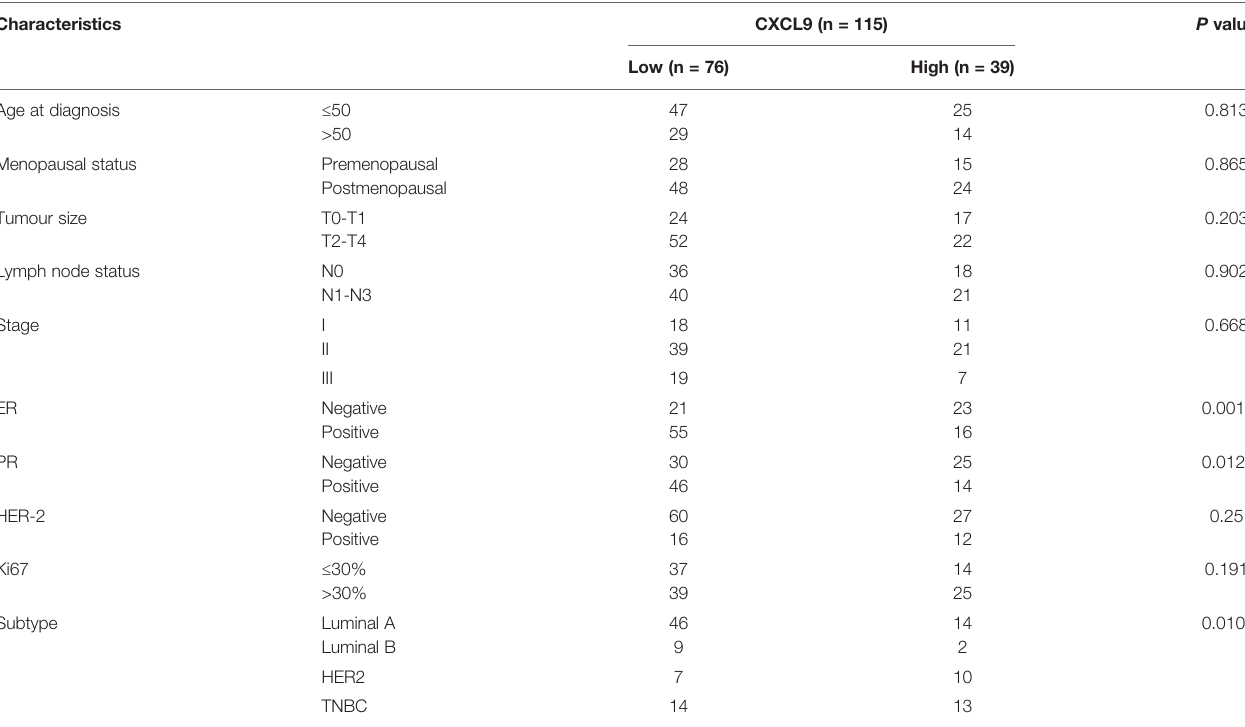
TABLE 1 | Correlation between CXCL9 expression and clinicopathological characteristics in patients with breast cancer.